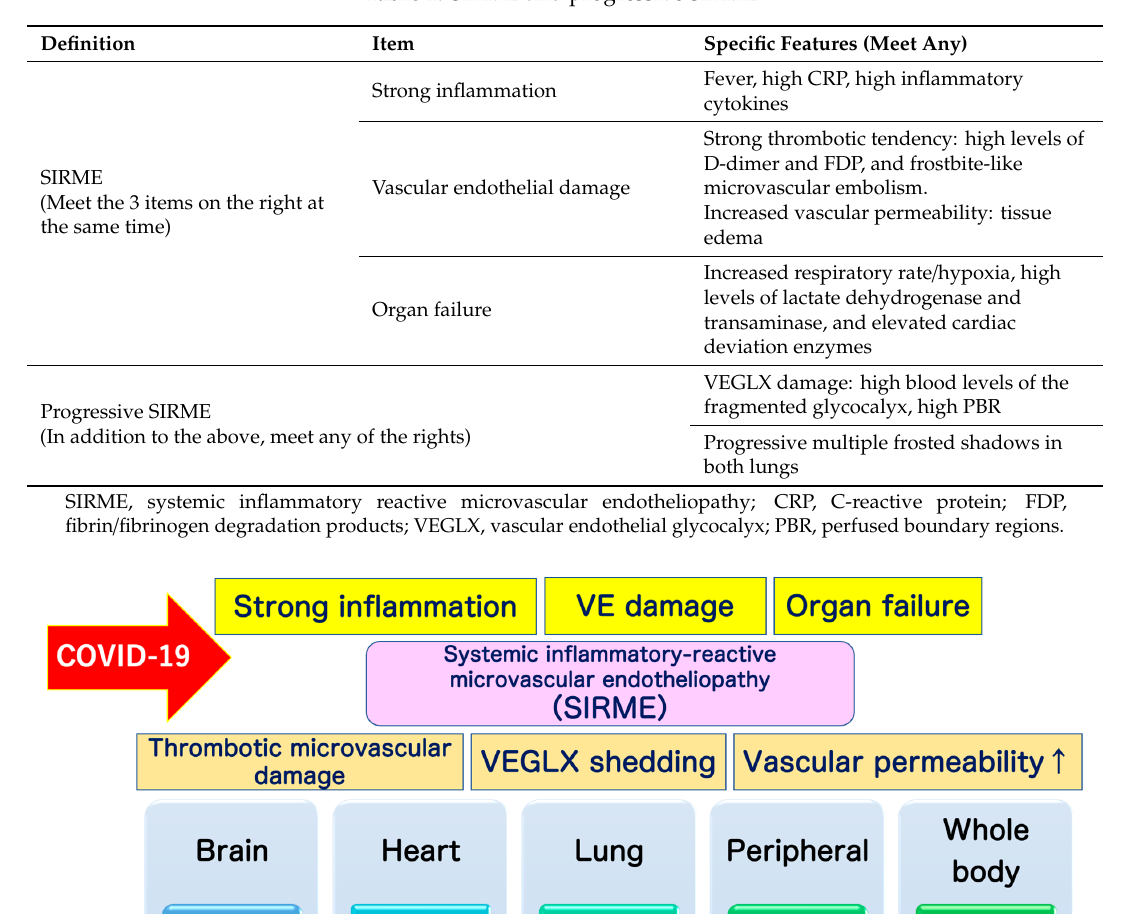
Table 1. SIRME and progressive SIRME.